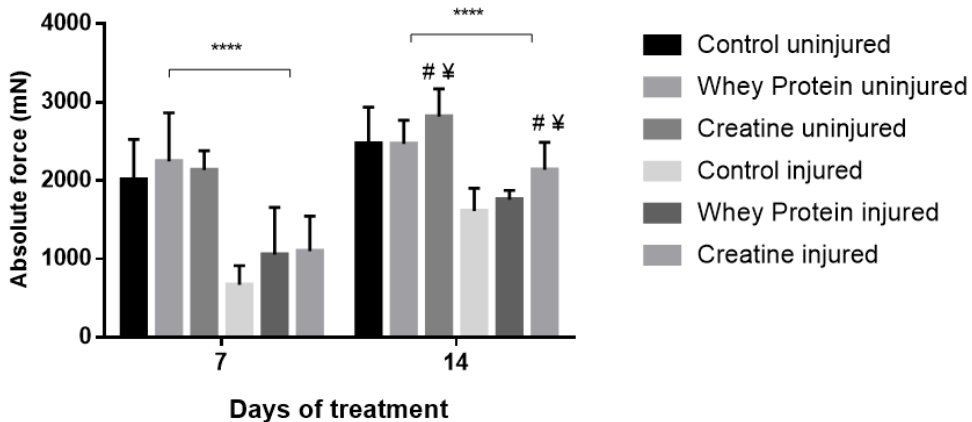
Figure 1. Absolute forces (Po) of uninjured and injured EDL muscles from rats treated with standard rat chow- (CON-), whey protein- (WP-), or creatine- (CR-) supplemented rat chow at day 7 and 14 post-injury. Values are mean ± SD. **** ( p < 0.0001) significantly different from contralateral values. # ( p < 0.05) significantly different from CON muscles at day 7 and/or day 14 post-injury. ¥ ( p < 0.05) significantly different from WP-supplemented muscles at day 7 and/or day 14 post-injury.